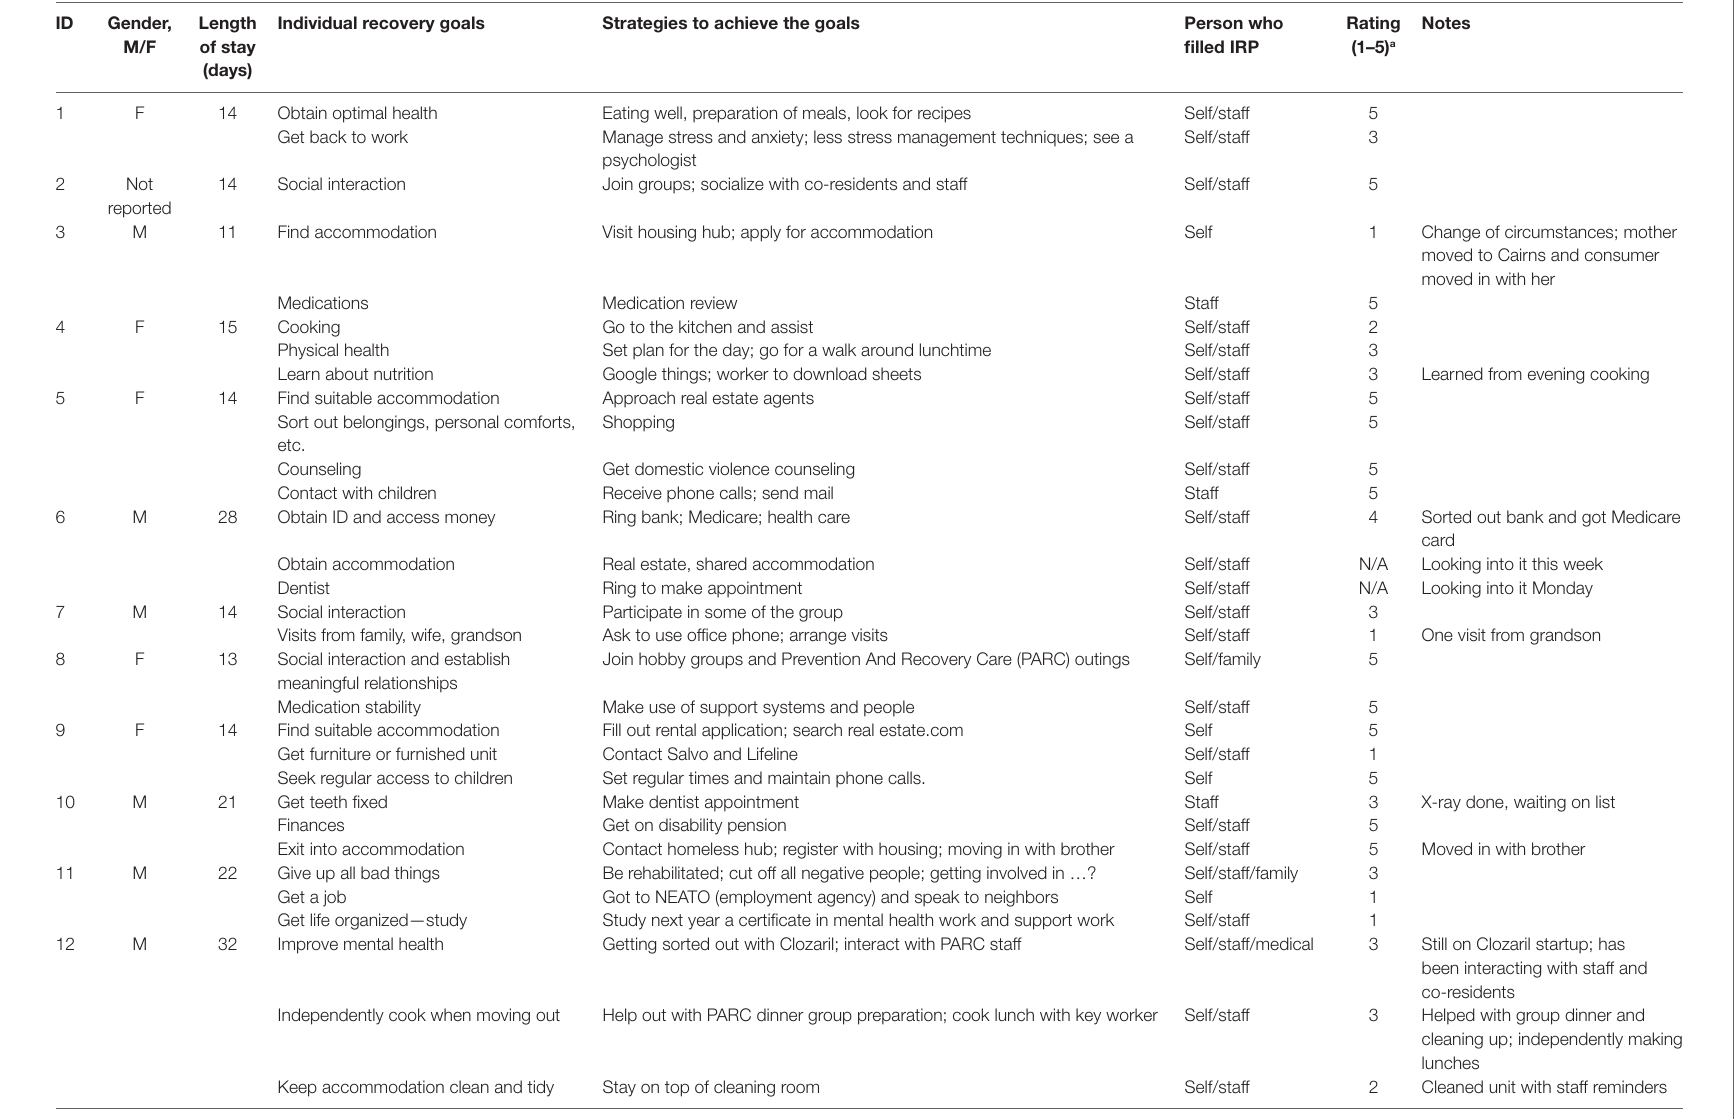
taBlE 3 | Characteristics of